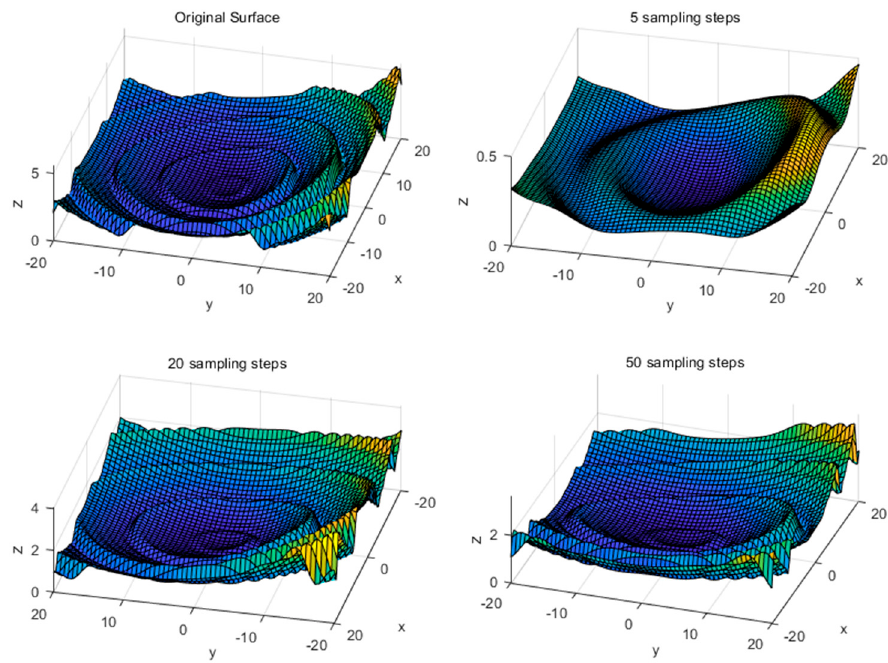
Figure 13. The decoupled surface of the tactile sensor under different sampling steps.